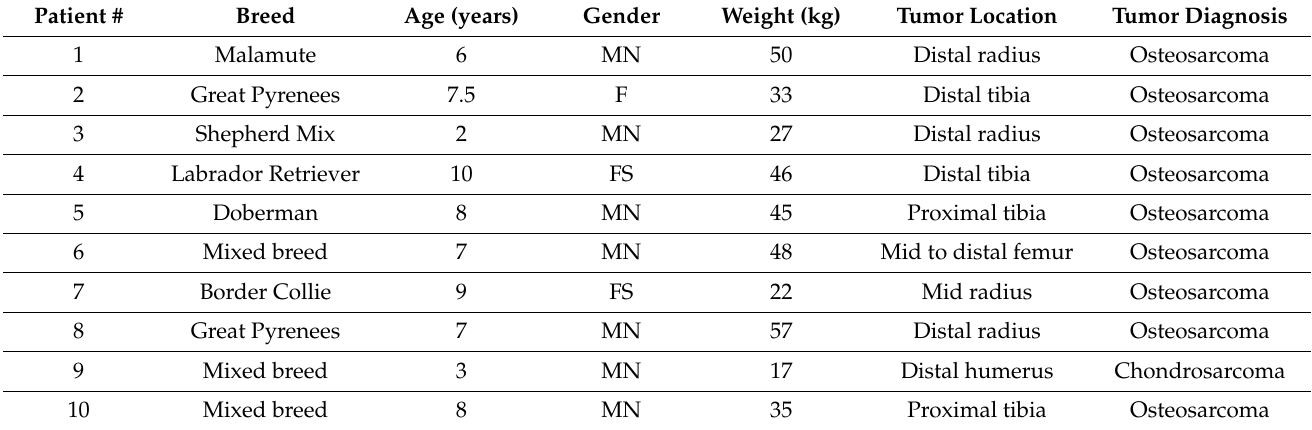
Table 1. Characteristics of the canine patients and primary bone tumors. Patients are ordered by the date of histotripsy